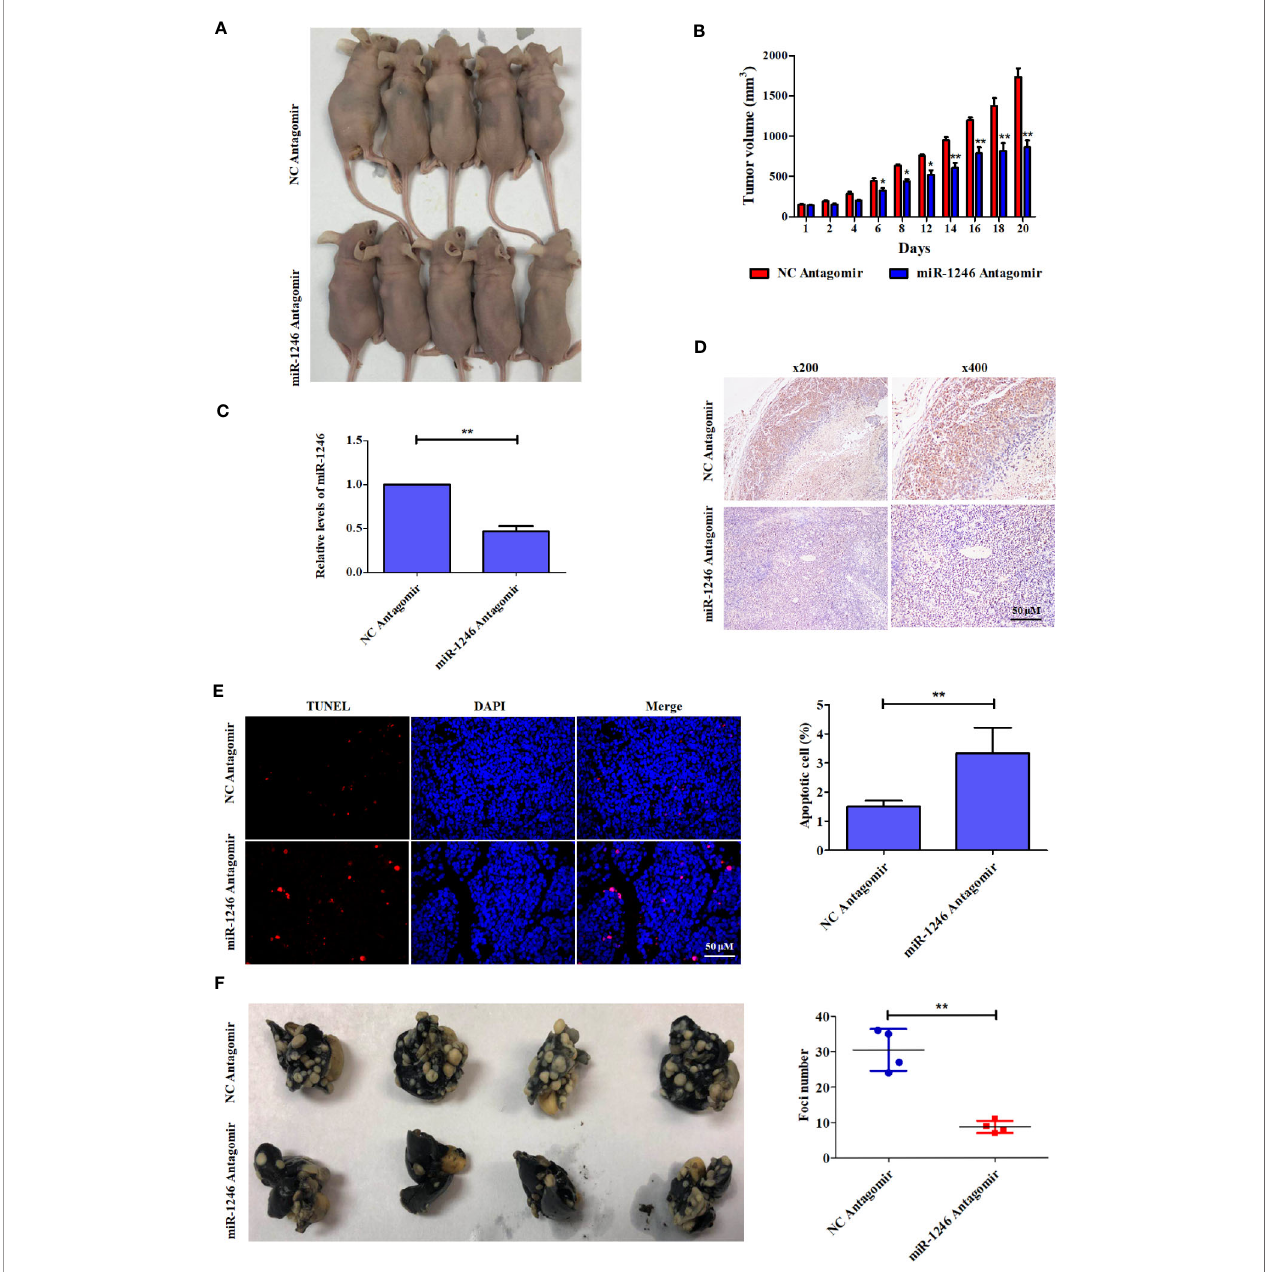
FIGURE 6 | Antagonist of miR-1246 suppressed the drug resistance and metastasis of breast cancer cells in animal model. (A) 5x10 6 MDA-MB-231 cells were subcutaneously inoculated into each female athymic mouse. After tumors formed, the tumor-bearing mice were randomized into four groups, each with fi ve mice. The control mice were treated with 50 nM NC antagomir intravenously every two days for total 20 days. The treatment groups were injected intravenously with 50 nM miR-1246 antagomir for the same frequency and time. All mice were treated with Doc at dose of 30 mg/kg every 2 days for total 20 days. Tumor size was measured in 3 diameters with micrometer caliper every two days to permit calculation of tumor volume. (B) Quantitative analysis of tumor size was performed. Data are expressed as the mean ± S.E.M. n=5. *P < 0.05 vs. control. (C) The expression of miR-1246 in tumors were measured by qPCR, Data are expressed as the mean ± SD. n=5. *P < 0.05 vs. control. (D) IHC assay was used to detect the NFE2L3 expression and the presentative images were shown. (E) TUNEL assay was used to detect the cell apoptosis. The presentative pictures were shown (left panel) and quantitative analysis of cell apoptosis was performed (right panel). Data were presented as mean ± S.D, **P < 0.01 versus control group. (F) 3x10 6 MDA-MB-231 cells were injected intravenously to constructed the metastasis mouse model. The control mice were treated with 50 nM NC antagomir intravenously every two days for total 20 days. The treatment groups were injected intravenously with 50 nM miR-1246 antagomir for the same frequency and time. The lungs were obtained and fi xed after the mice were sacri fi ced, and the tumor foci number was counted. The pictures of the lungs were presented (left panel) and quantitative analysis of foci number was performed (right panel). Data were presented as mean ± S.D. N=4. **P < 0.01 versus control